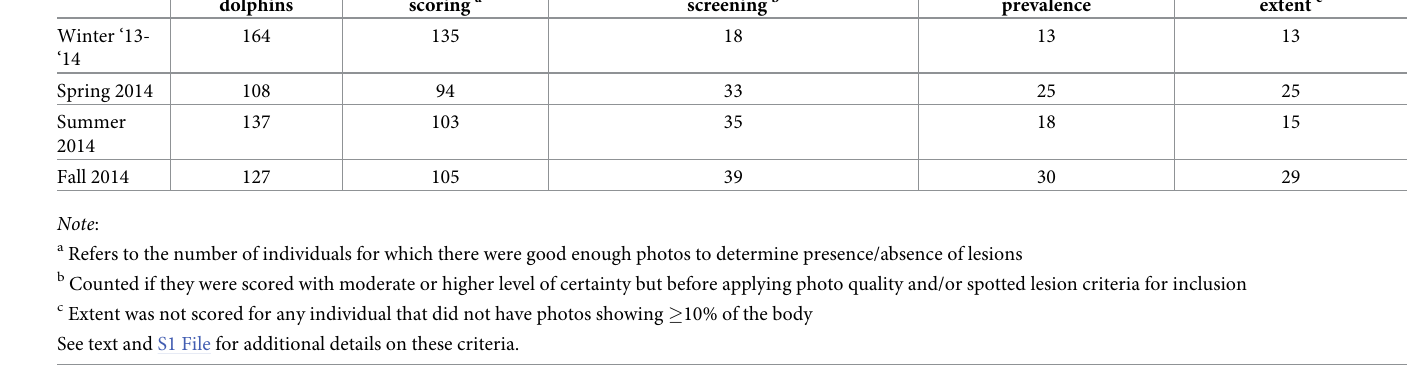
there were consistently more hypopigmentation cases and very few cases of hyperpigmenta- tion; however, several darker lesion types like tattoo lesions and dark, black spots were included in the PP category instead, so hyperpigmentation only included remaining dark patches of unknown etiology, not all hyperpigmentation cases. the three seasons following the flood. Sixteen of these that did not show lesions prior to the flood (winter 2013–2014), were seen with lesions at least once following the flood, resulting in a statistically significant increase in the proportion of individuals with skin lesions from pre- to post-flood (data collapsed across post-flood seasons; McNemar’s exact test; n = 71; p < 0.001). When each post-flood season was compared independently to the pre-flood season however, not all demonstrated a significant increase in prevalence. Of the 33 individuals seen in both the winter and spring, there was no significant change in the prevalence of skin lesions over that time period. The same was true for the comparison of the 33 individuals seen in both winter and summer (McNemar’s exact tests with Bonferroni adjustment for multiple tests; p > 0.02). However, there was a significant increase in the proportion of dolphins with skin lesions in the fall compared to those same individuals ( n = 38) that were seen prior to the flood ( p = 0.01).